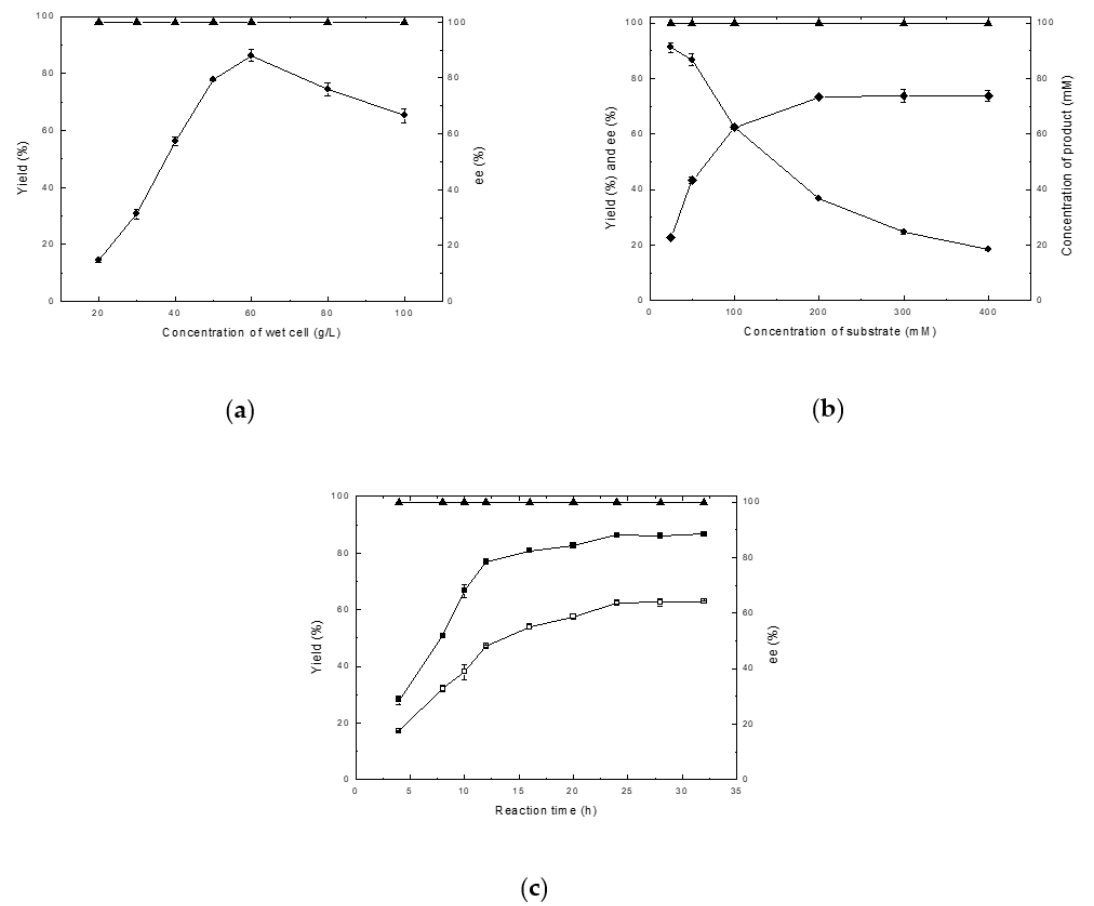
Figure 2. Effects of cell concentration. ( a ) Substrate concentration; ( b ) reaction time ( c ) on the asymmetric reduction of 4-(trifluoromethyl)acetophenone in phosphate buffer. Symbols: ( ● ) Yield and ( ▲ ) ee; ( ◆ ) product concentration; ( ■ ) yield at 50 mM 4-(trifluoromethyl)acetophenone and ( □ ) yield at 100 mM 4-(trifluoromethyl)acetophenone.